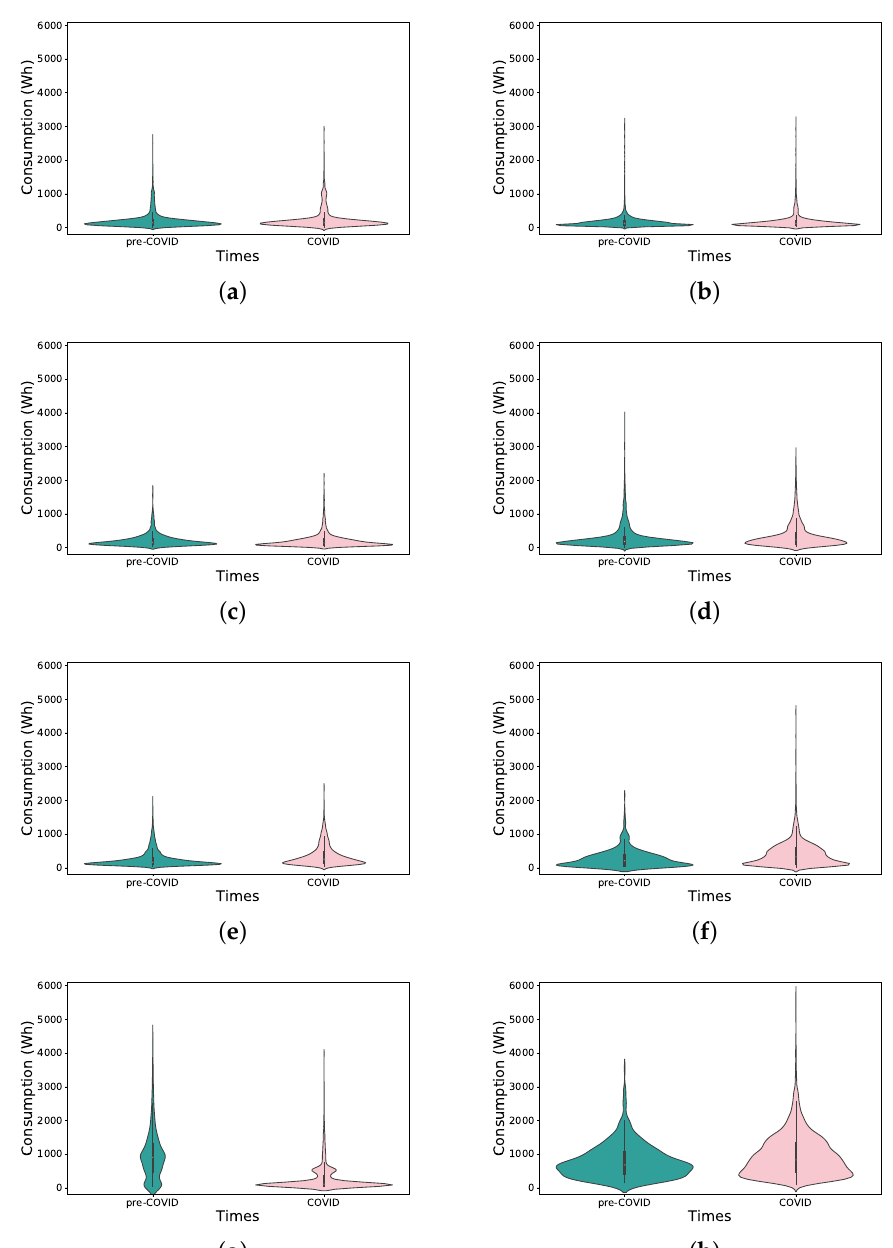
Figure 1. Statistical interpretation of consumption data ( a ) H1, ( b ) H2, ( c ) H3, ( d ) H4, ( e ) H5, ( f ) H6, ( g ) H7, and ( h )